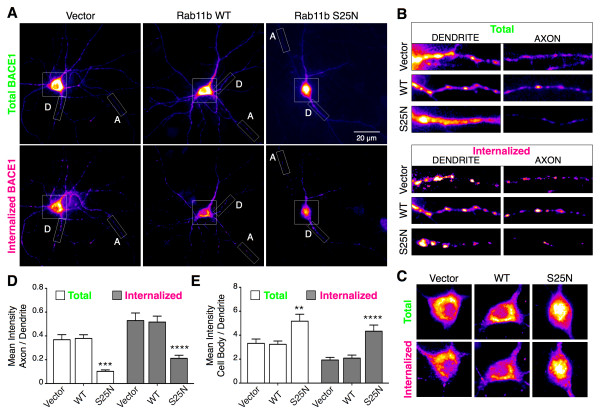
Rab11b GTPase activity regulates axonal targeting of BACE1. (A) DIV12 neurons co-transfected with BBS-BACE1-YFP and mCherry-Rab11b WT or Rab11bS25N dominant-negative mutant were labeled with AF647-BTX uptake followed by an acid wash to selectively visualize internalized BACE1. Dendrites and axons were identified by MAP2 immunostaining of fixed neurons. The pseudocolor images depict total (YFP) and internalized BACE1 (BTX) fluorescence intensities in the same neuron. (B) Higher magnification of dendrite and axon segments (rectangle boxes) of neurons shown in A. (C) Higher magnification of the cell bodies (square boxes) of neurons shown in A. (D) Mean axon-to-dendrite fluorescence intensity ratios for total (YFP) and internalized BACE1 (BTX) were quantified from individual neurons cotransfected with BACE1 and empty vector, Rab11b WT or Rab11S25N (n = 14-15 neurons each). (E) Mean cell body-to-dendrite fluorescence intensity ratios for total and internalized BACE1 were quantified. Note that expression of Rab11S25N resulted in a significant decrease of axonal BACE1 localization and an increase of BACE1 levels in the cell body.